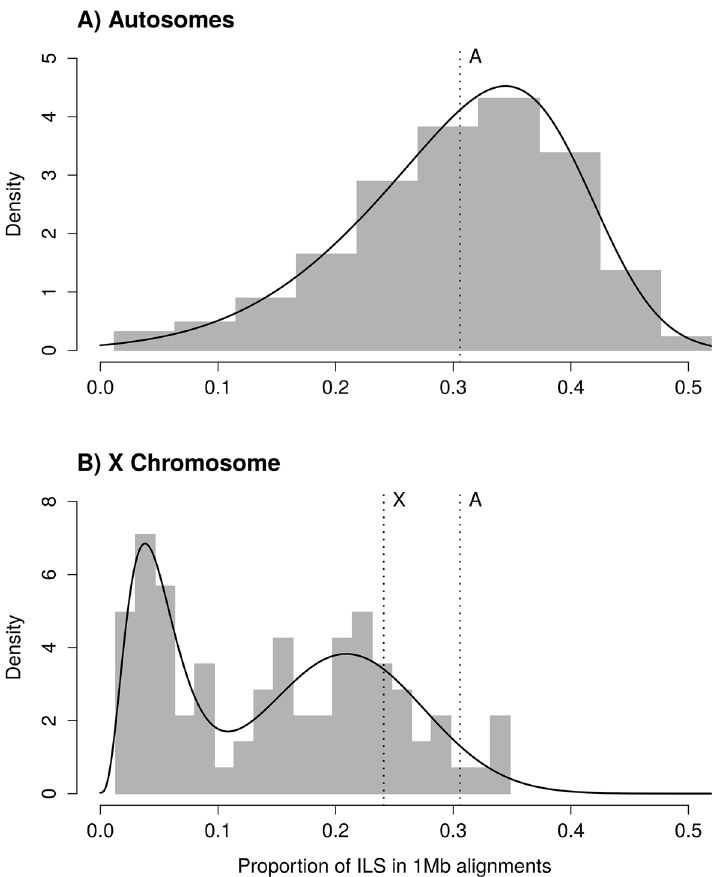
Fig 1. Distribution of incomplete lineage sorting (ILS) along the human genome for autosomes (A) and the X chromosome (B). Grey bars show the distribution of ILS as estimated from the posterior decoding of the CoalHMM model. Solid black lines show the best fit of a skewed normal distribution in (A) and a mixture of a gamma and a Gaussian distribution in (B). The A-labeled vertical line show the median of ILS on the autosomes (A), reported on the X chromosome (B). The X-labeled vertical line shows the expectation of ILS on the X chromosome based on the estimate of ILS on the autosomes (assuming an effective population size three quarters of the effective population size of the autosomes). The second mode of the distribution of ILS on the X chromosome matches this expectation.